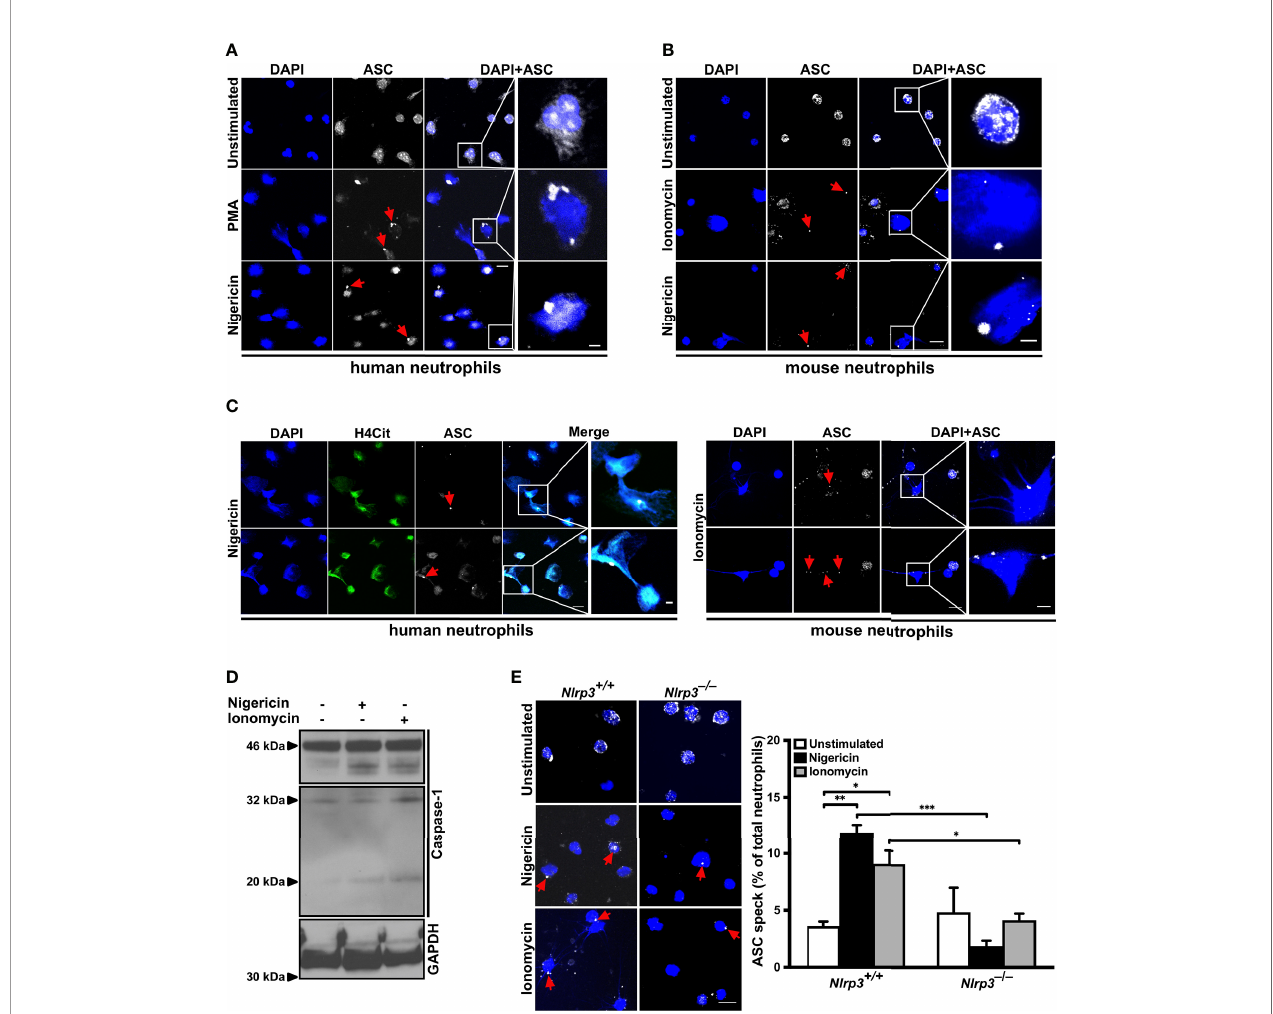
FIGURE 1 | NLRP3 in fl ammasome-dependent ASC speck formation and release on NETs by stimulated neutrophils (A) Confocal microscopy images of immunostained human neutrophils in the absence (unstimulated) or presence of PMA (50 nM) or nigericin (15 µM) for 4 hours. Blue, DNA (DAPI); grey, ASC antibody staining. Red arrows indicate ASC speck. Scale bar equals 10 µm in the overview and 2.5 µm in the zoom panel. Representative of n=4 experiments. (B) Confocal microscopy images of immunostained mouse neutrophils in the absence (unstimulated) or presence of ionomycin (4 µM) or nigericin (15 µM) for 4 hours. Blue, DNA (DAPI); grey, ASC antibody staining. Red arrows indicate ASC speck. Scale bar equals 10 µm in the overview and 2.5 µm in the zoom panel. Representative of n=5 experiments. (C) Confocal microscopy images of ASC speck formation in NETting cells and associated with NETs in human (left panel) or mouse neutrophils (right panel) in the presence of nigericin (15 µM) or ionomycin (4 µM). Blue, DNA (DAPI); green, H4Cit antibody stain; grey, ASC antibody staining. Red arrows indicate ASC speck. Scale bar equals 10 µm in the overview and 2.5 µm in the zoom panel. Representative of n=4-5 experiments. (D) Western blot of caspase-1 cleavage (antibody clone: Casper-1) in neutrophils from wild-type mice in the absence or presence of nigericin (15 µM) or ionomycin (4 µM) for 0.5 hours. Representative of n=3 experiments. (E) Representative confocal microscopy images (left panel) and arithmetic means ± SEM (right panel; n=4-5 mice) of ASC speck formation in neutrophils from wild-type ( Nlrp3 +/+ ) or Nlrp3 – / – mice in the absence (unstimulated, open bars) or presence of nigericin (15 µM, black bars) or ionomycin (4 µM, grey bars) for 4 hours. Blue, DNA (DAPI); grey, ASC antibody staining. Red arrows indicate ASC speck. Scale bar equals 10 µm. * p<0.05, ** p<0.01 and ***